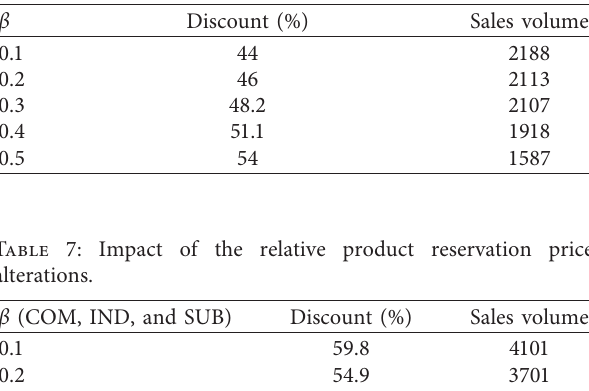
Table 6: Impact of the product reservation price alterations.